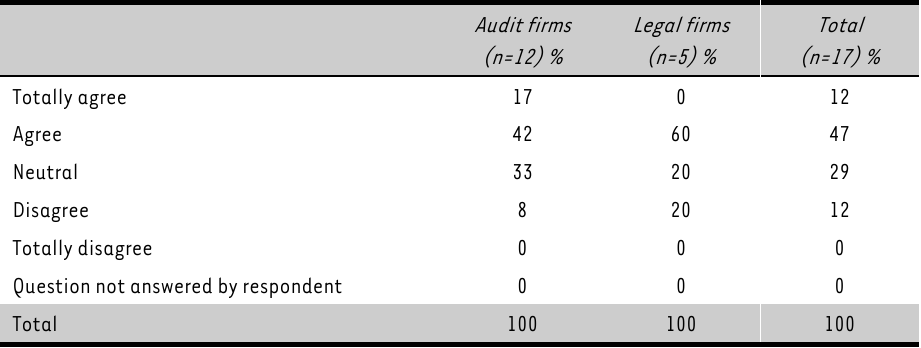
TABLE 13: Results of question